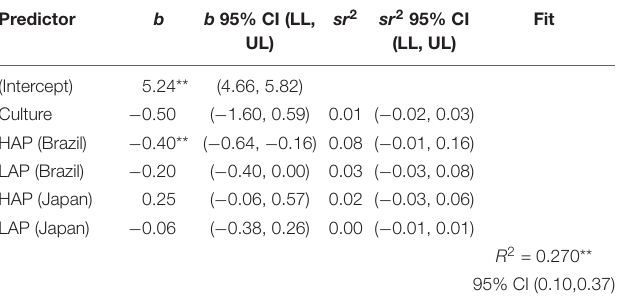
TABLE 2 | Regression results using NHR as the criterion, actual affect as the dependent variable and culture (Brazil and Japan) as dummy variables.